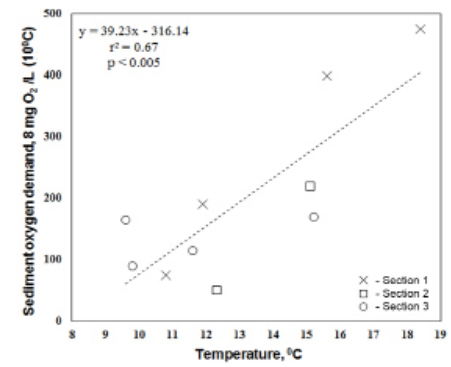
m -2 h -1 ) at fixed 2